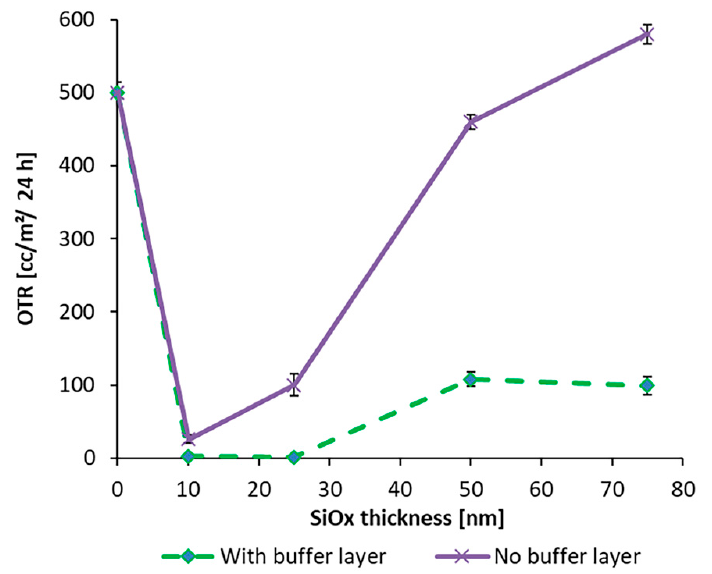
Figure 8. OTR values for coated PBS samples as a function of SiO x thickness with and without buffer layer. Error bars are related to the standard deviation of a set of three measurements.